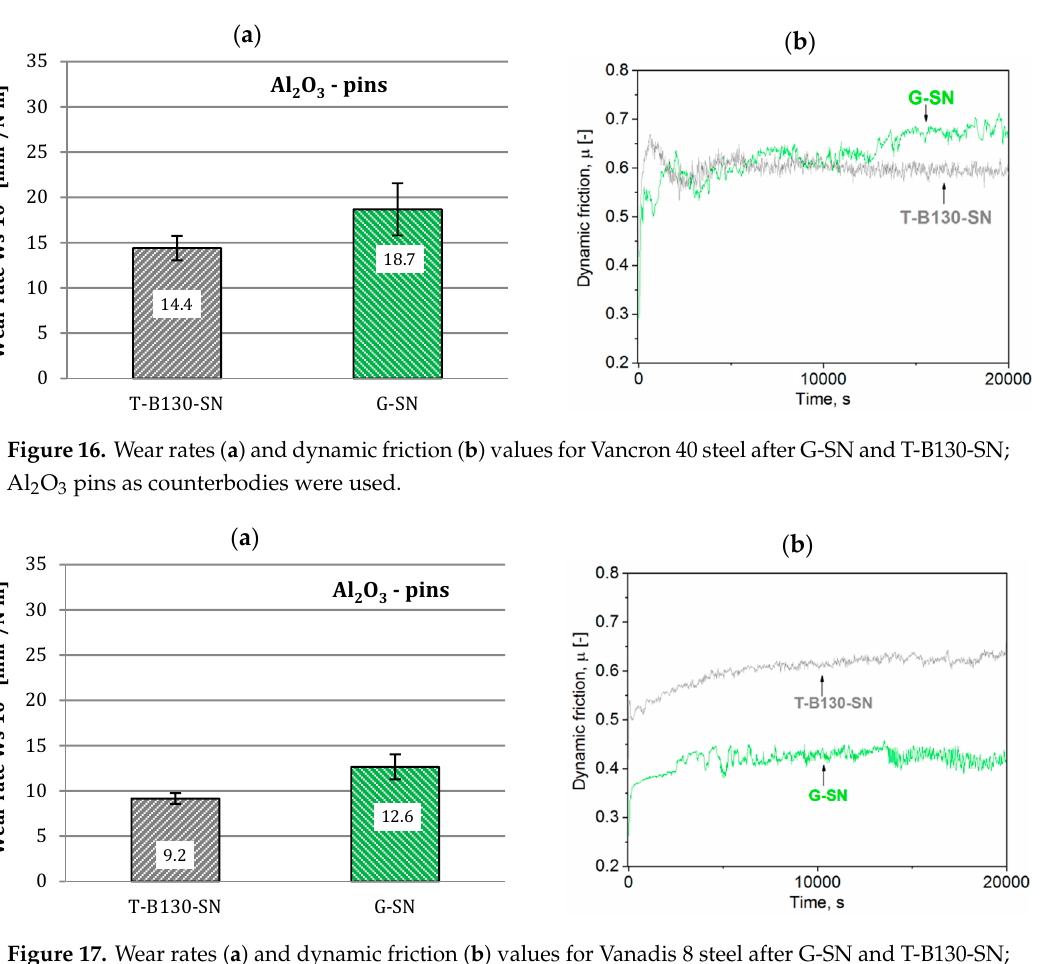
Figure 18. SEM images of wear traces (with energy dispersive X-ray spectrometer (EDS) mapping analysis) created after the tribological test using the pin-on-disc method on Vanadis 8 steel samples, subjected to selected variants of surface treatment: ( a ) G-SN and ( b ) T-B130-SN. 4. Conclusions The following conclusions can be formulated: